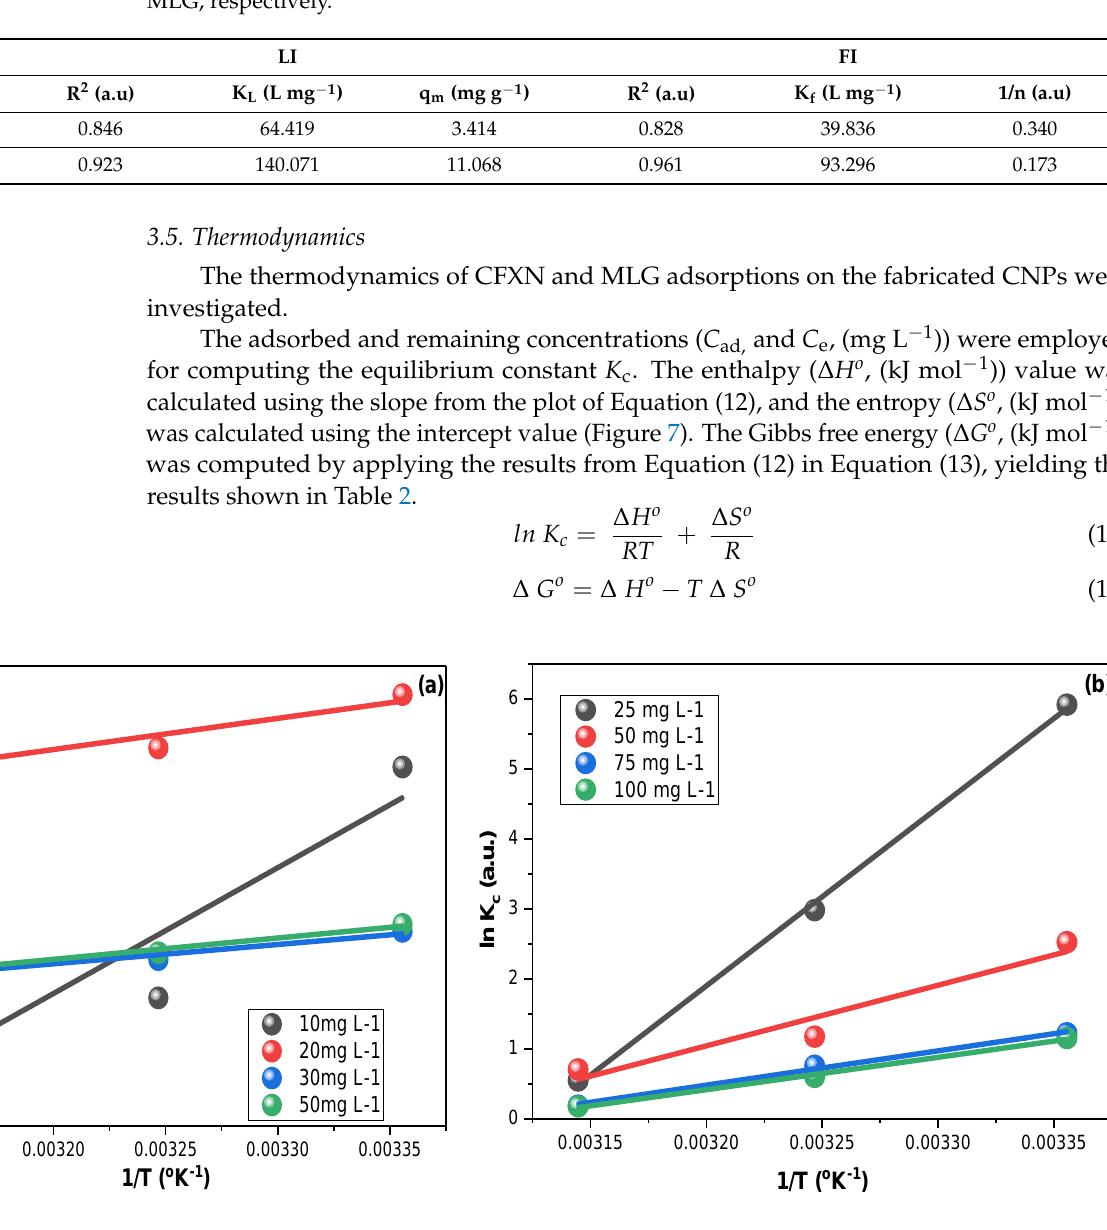
Figure 7. The thermodynamic results for the adsorption of ( a ) CFXN and ( b ) MLG on the CNPs within a temperature range of 25 °C to 45 °C using 10, 20, 30, and 50 mg L −1 CFXN solutions and 25, 50, 75, and 100 mg L − 1 MLG solutions.